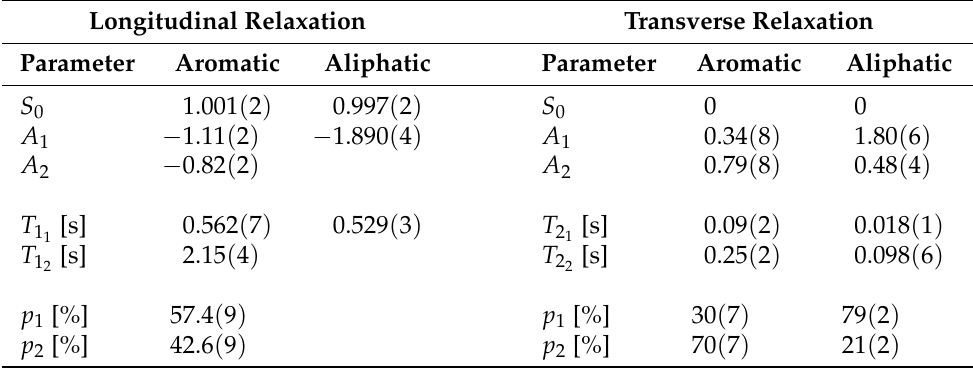
Table 1. Fit parameters used to fit the in Figure 6 shown relaxation curves of protons in a solution consisting of 150g/L asphaltene in benzene-d 6 , using Equations (13) and